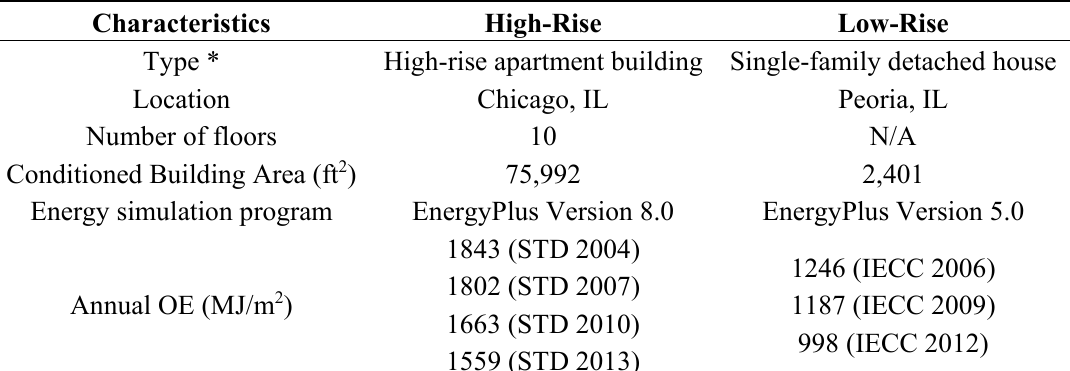
Table 3. Characteristics of the high-rise and low-rise residential prototype